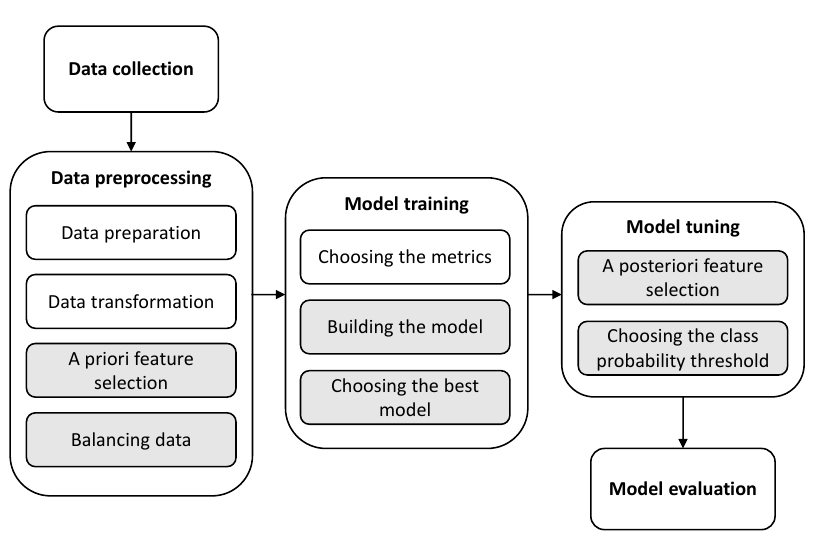
Figure 3. Predictive modelling process for bathing water quality.